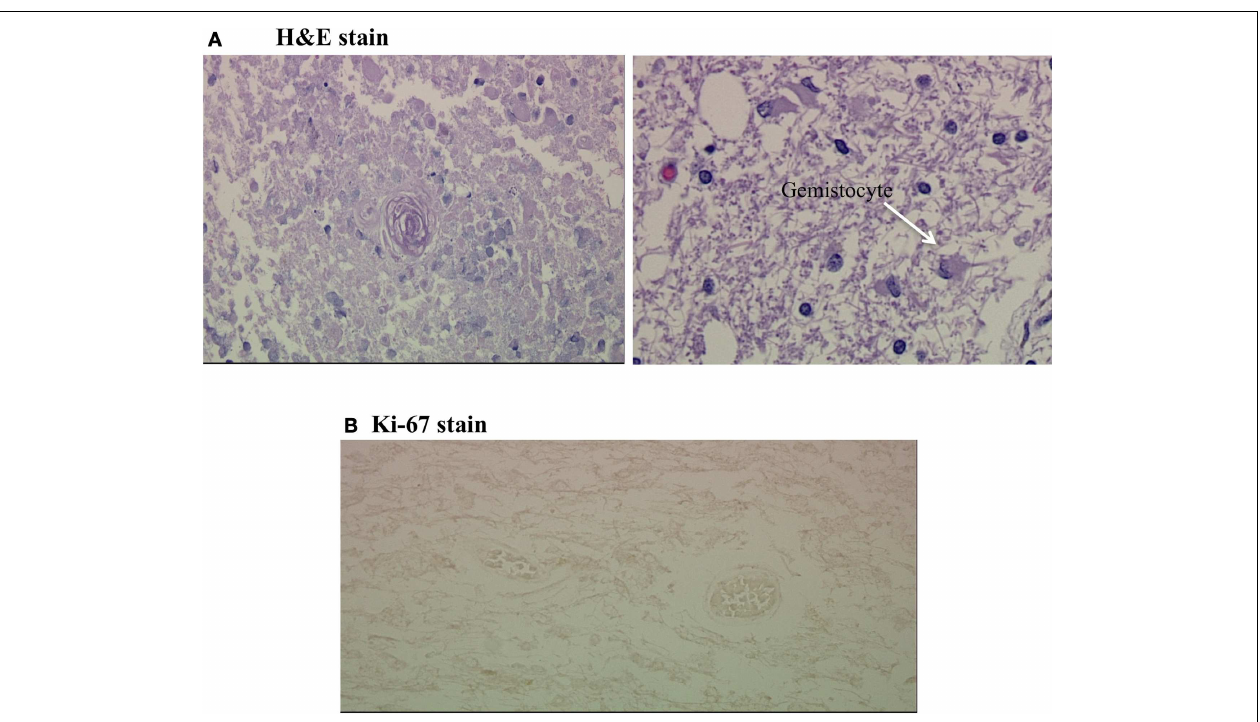
the second demonstrates scattered gemistocytes on a background of edematous white matter. (B) is a Ki-67 stain of this region, which was completely